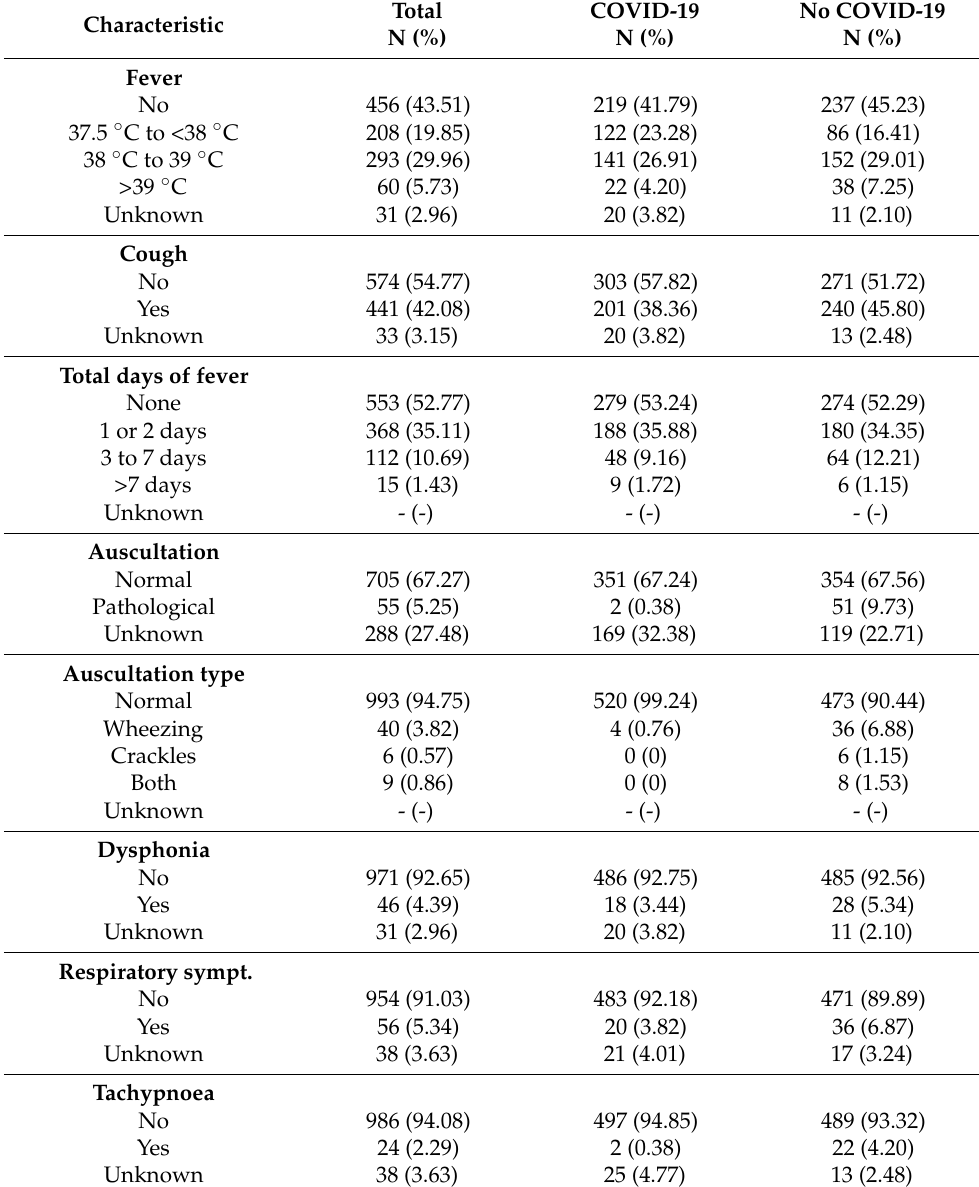
Table 2. Specifications of the dataset used to train the predictive model of COVID-19 in paediatric- aged